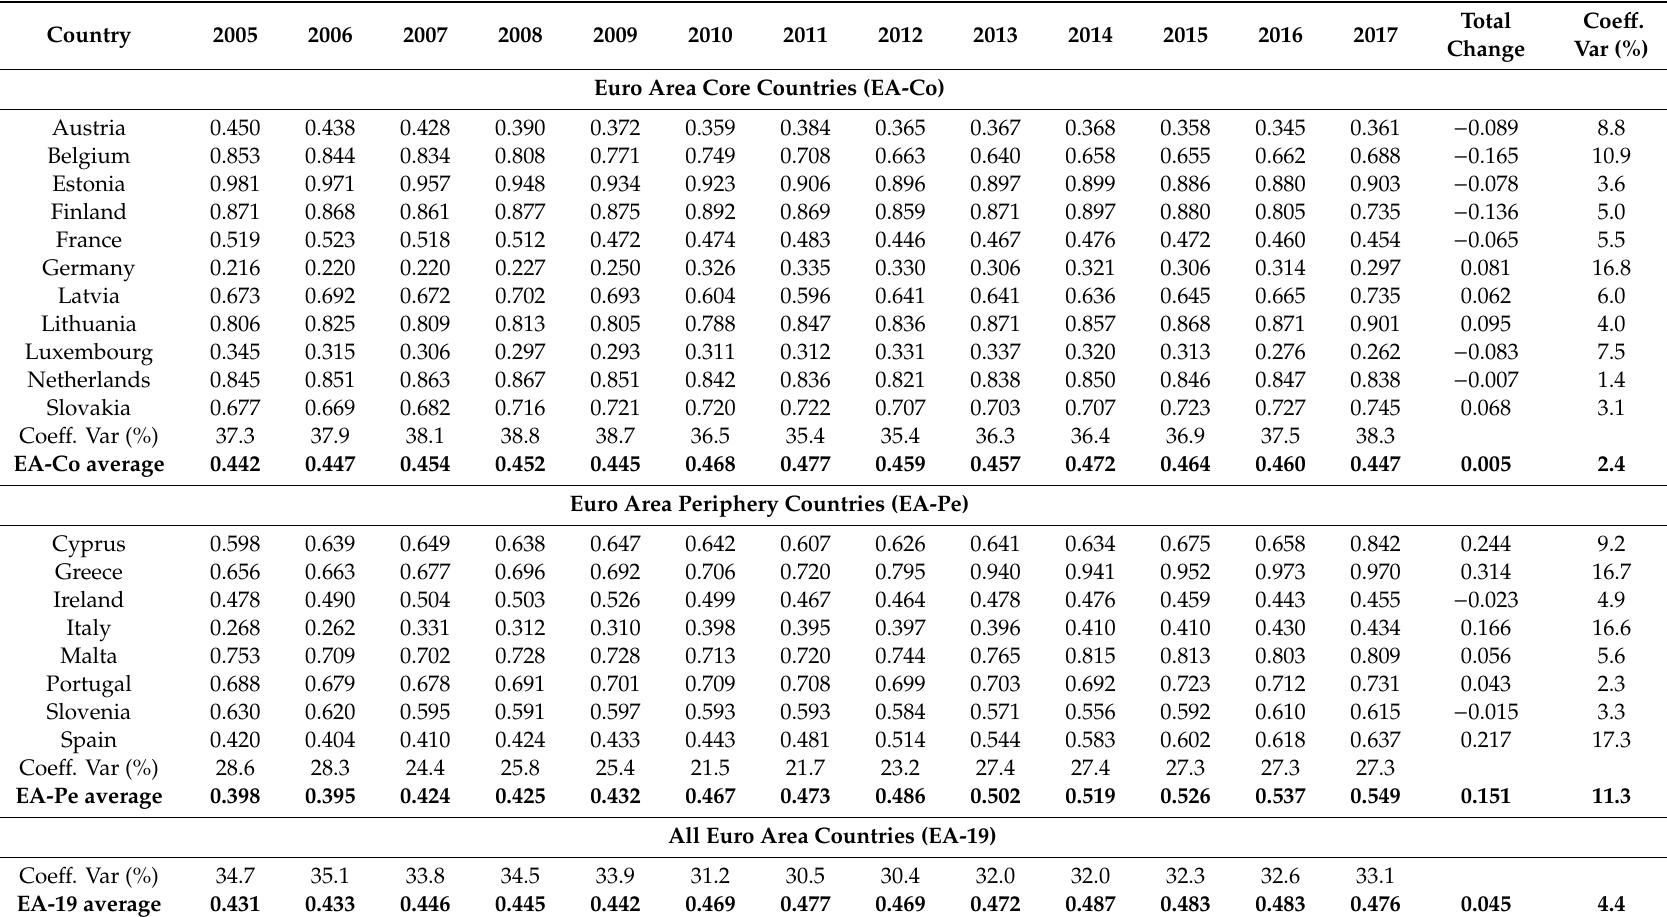
Table 3. Evolution of concentration (market share of the five largest banks, CR5).